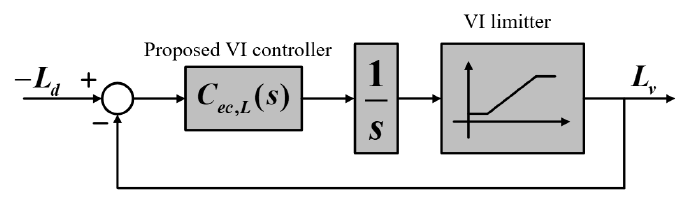
Figure 6. Control block diagram of a VI controller [33].